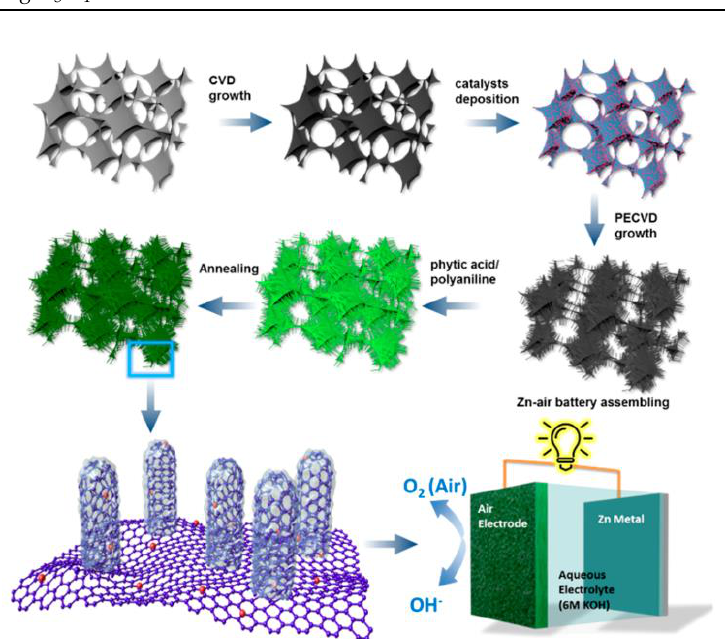
Figure 4. Procedure for synthesizing P- and N-doped vertically aligned carbon nanotubes on graphene foam (NP − VACNTs − GF). Reproduced with permission from [60]. Copyright 2019 American Chemical Society. Table 3. Physicochemical properties of PA-derived carbon materials obtained by post-modification. Electrocatalyst